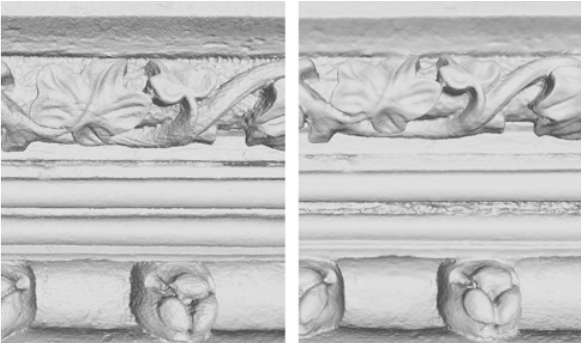
Figure 5. Model comparison - Acute 3D (left) and PhotoScan(right).